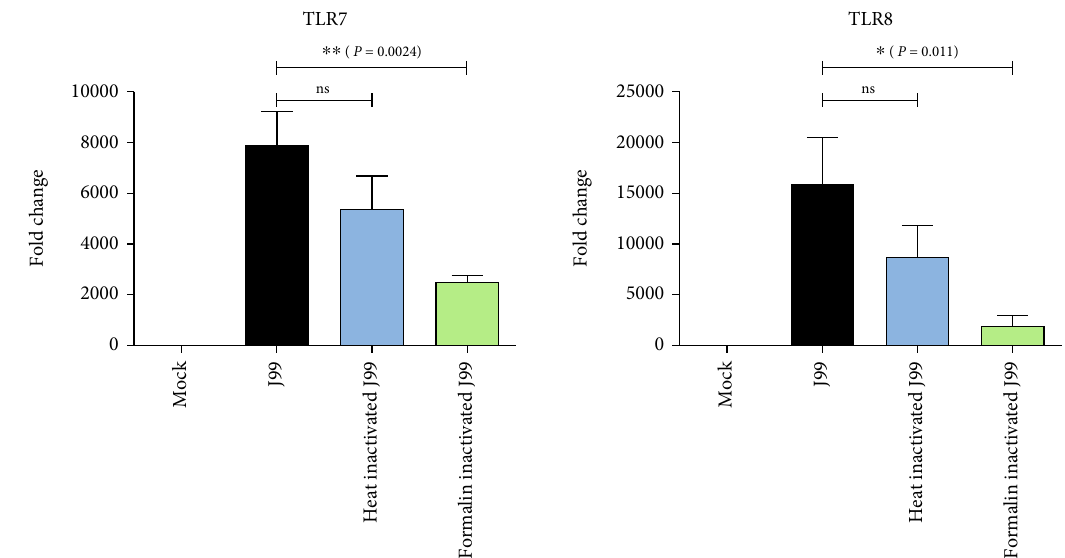
Figure 3: Expression levels of TLR7 and TLR8 transcripts in the THP-1 cells infected with live and death bacteria. THP-1 cells were uninfected (mock) or exposed to live, heat-, or formalin-inactivated H. pylori J99 strain at MOI 10 for 16 hours. The relative expression of TLR7 and TLR8 mRNA transcripts relative to the β - actin endogenous housekeeping gene. Statistical signi fi cance was analyzed using Student ’ s t -test ( ∗ P ≤ 0 : 05 ; ∗∗ P ≤ 0 : 01 ; ns : not signi fi cant).